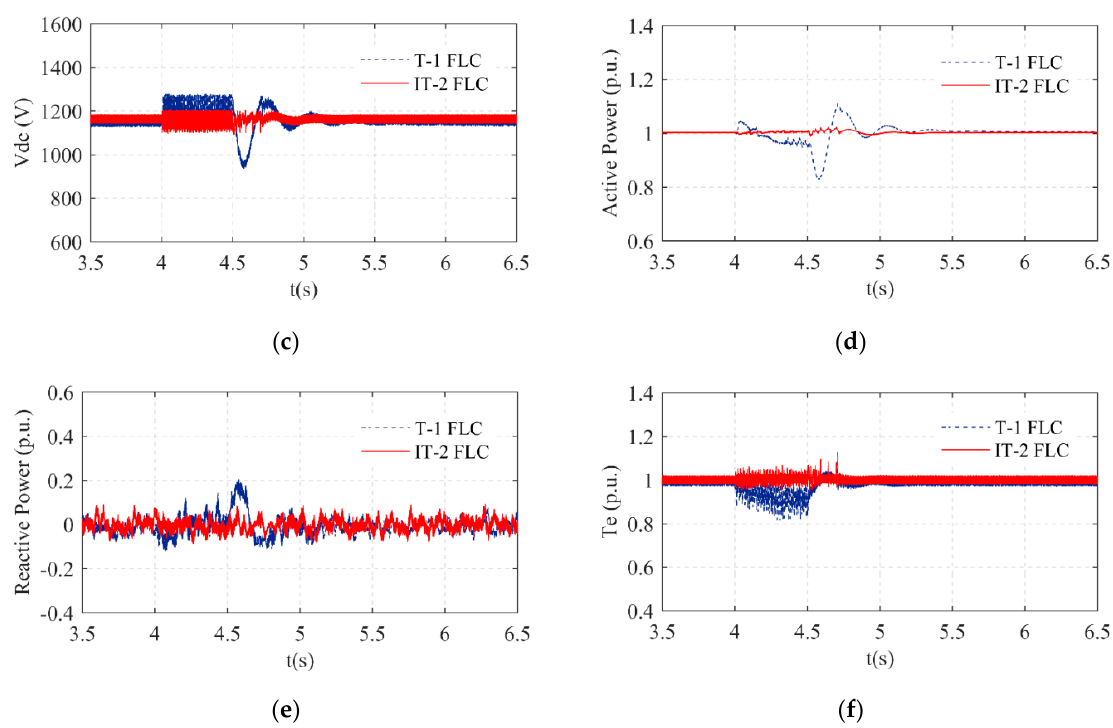
Figure 7 ( a – f ) . Dynamic response of a 1.5 MVA permanent magnet synchronous generator (PMSG) with the type-1 fuzzy logic control (T-1 FLC) and interval type-2 fuzzy logic control (IT-2 FLC) systems during a 1/ ϕ unsymmetrical fault.